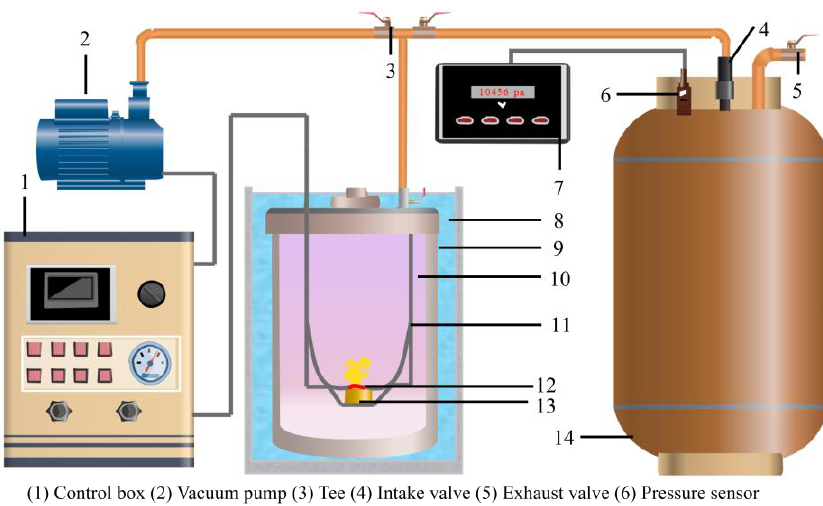
Figure 4. Structural diagram of calorimetric elastic gas specific volume test device.